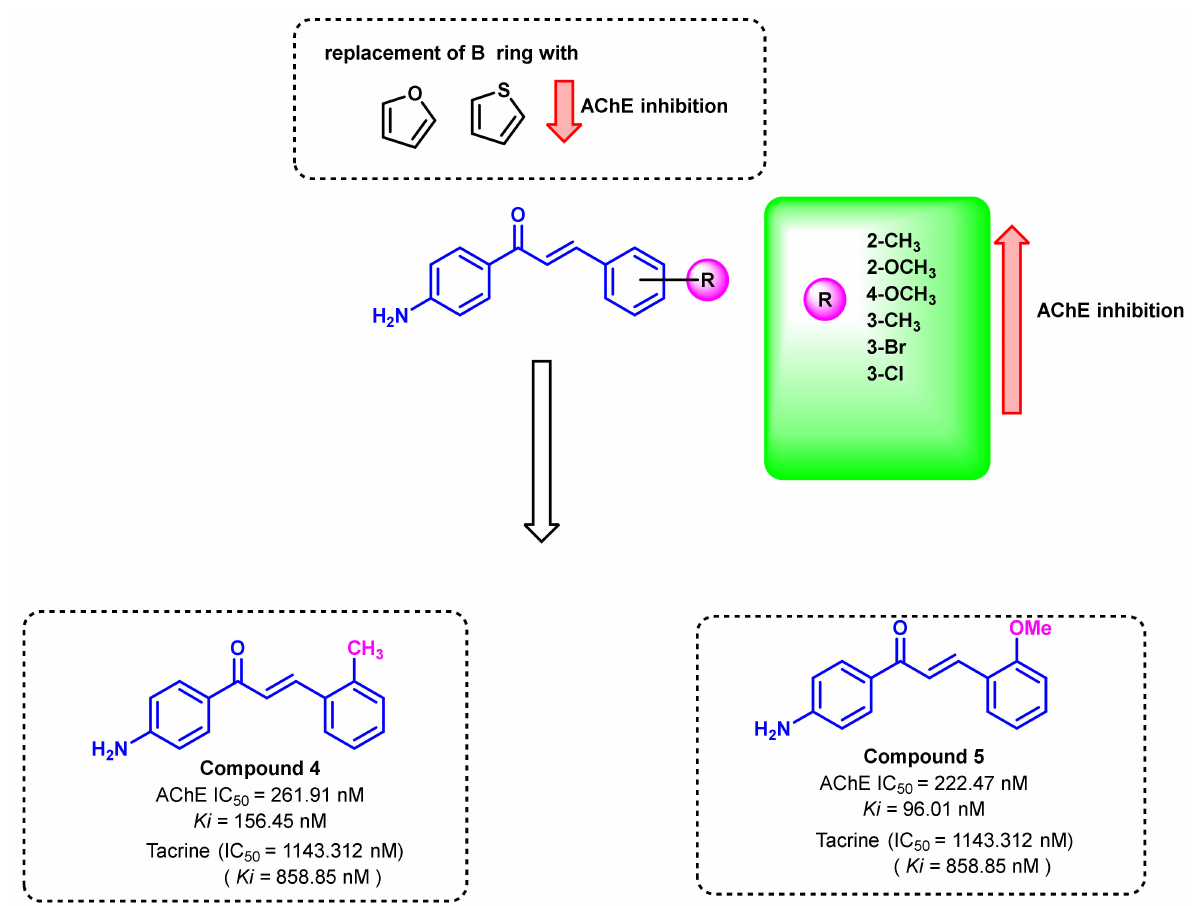
Figure 10. 4-amino chalcone derivatives reported by Gurdere et